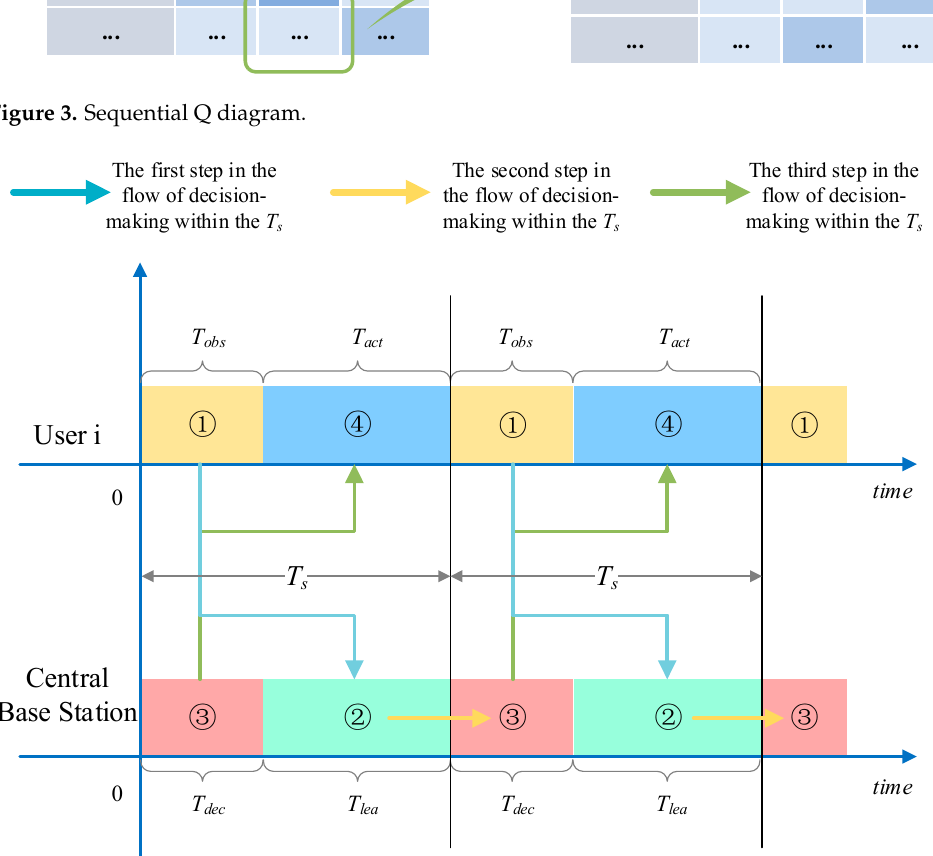
Figure 3. Sequential Q diagram.